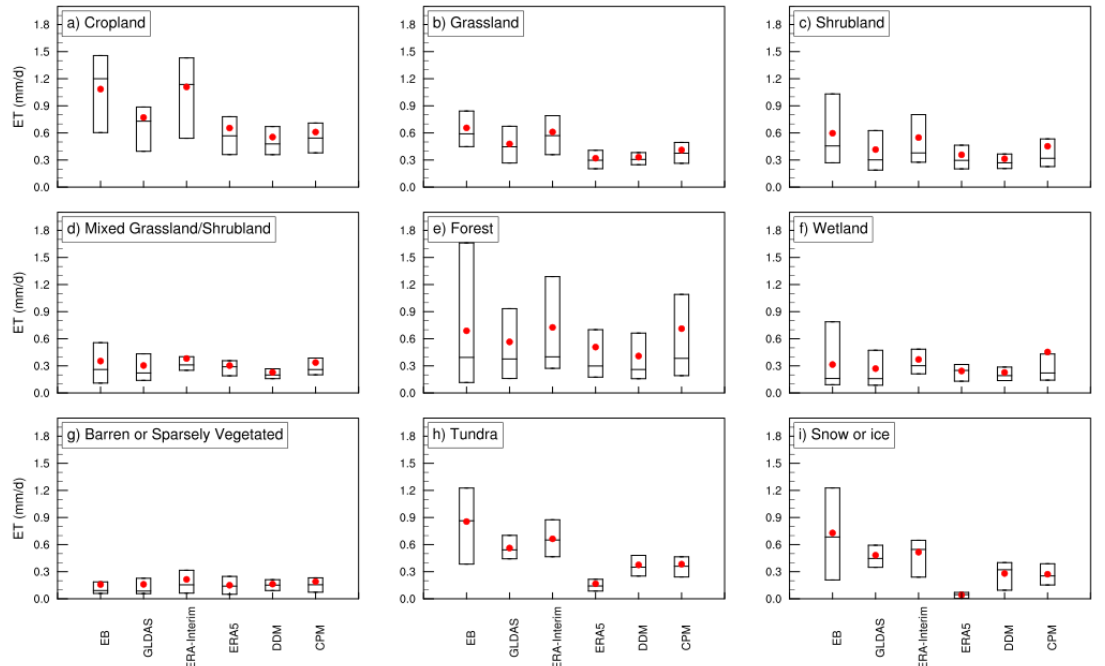
Figure 7. Box-and-whisker plots of ET of nine land-use categories based on six datasets for the non-monsoon season in 2014: ( a ) cropland; ( b ) grassland; ( c ) shrubland; ( d ) mixed grassland/shrubland; ( e ) forest; ( f ) wetland; ( g ) barren or sparsely vegetated; ( h ) tundra; ( i ) snow or ice (units: mm/d). The top and bottom of each box are the 20th and 80th percentiles in grid cells with the same land-use type. The lines in each box represent the median; red dots represent the mean .